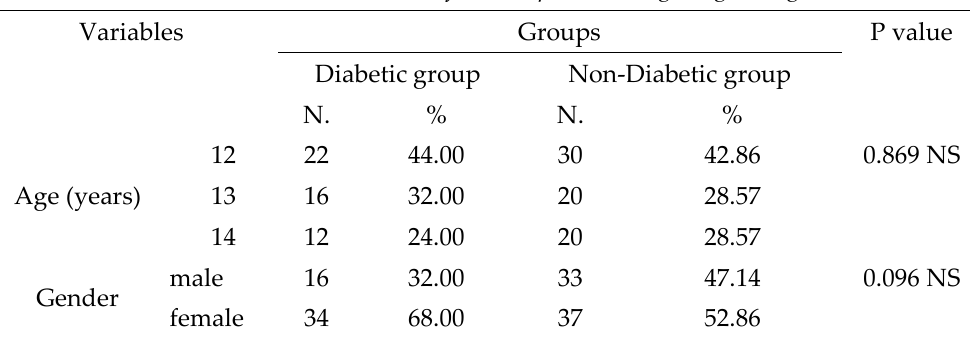
Table (1): Distribution of the sample according to age and gender Variables Groups